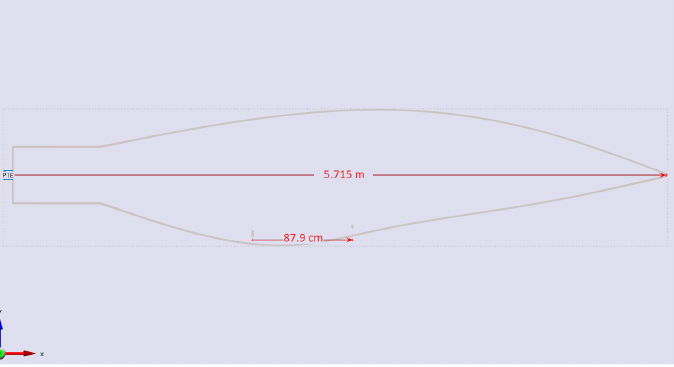
Figure 31. The rotor blade had two cracks.